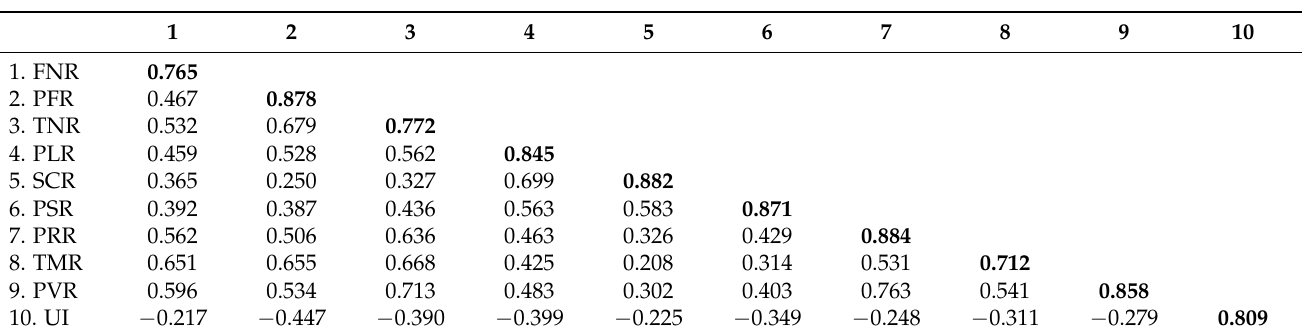
Table 4. Correlation matrix of